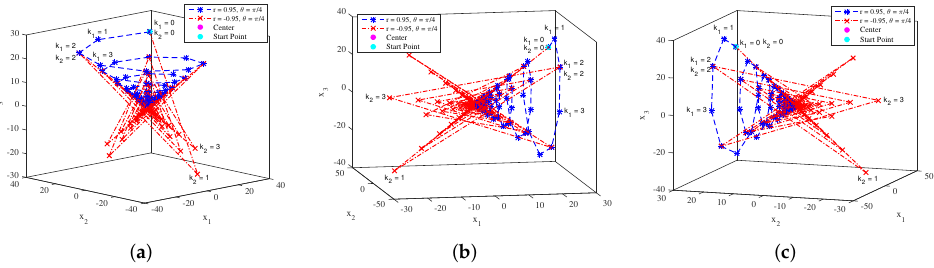
Figure 4. Conventional and hypotrochoid spiral trajectories for a three-dimensional system with r = 0.95 and θ = π : ( a ) on x 1 x 2 -plane with R 1,2 . ( b ) on x 2 x 3 -plane with R 2,3 . ( c ) on x 1 x 3 -plane 4 with R 1,3